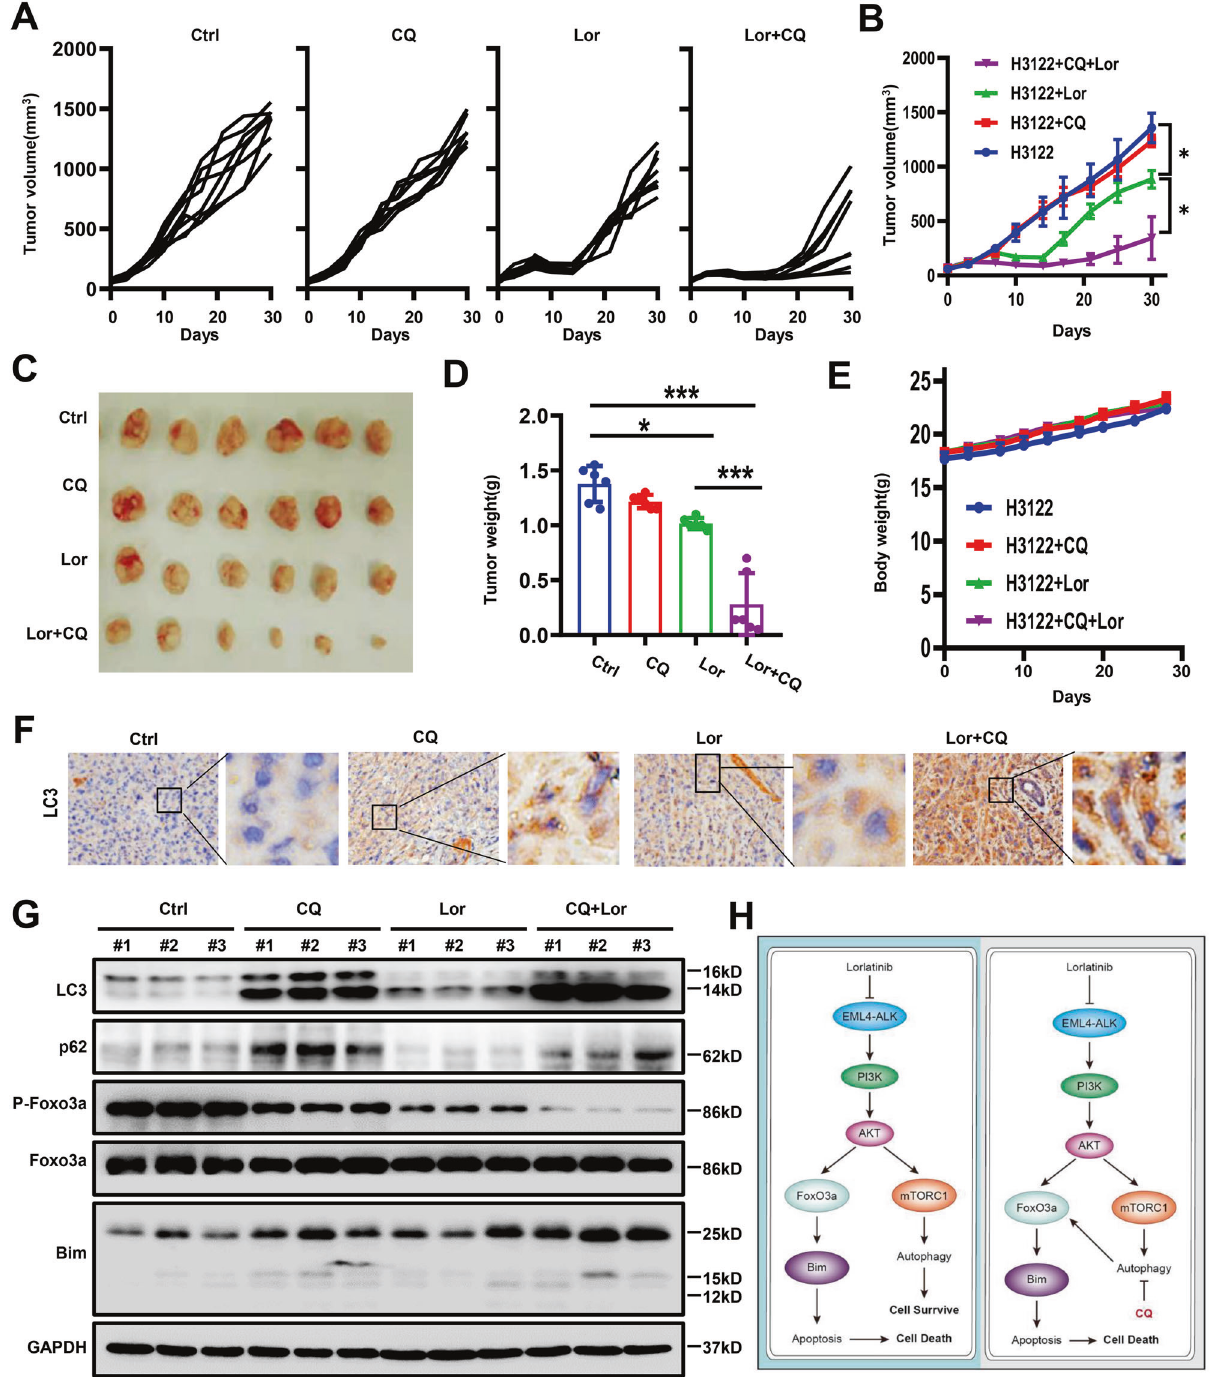
Fig. 5 Inhibition of tumors in vivo by lorlatinib and CQ. A , B Tumor sizes are presented as the mean ± S.E.M. ( n = 6); * P < 0.05. C Macroscopic appearance of H3122 xenografts treated with control, CQ, lorlatinib, and combined CQ/lorlatinib for 4 weeks. D Average tumor weight for each group was calculated. * P < 0.05. *** P < 0.001. E Body weight is presented as the mean ± S.E.M. ( n = 6). F Representative images of IHC staining of LC3. G Whole-protein cell lysates were prepared randomly from three tumors per group for western blot to detect the indicated proteins. H The mechanism served to enhance the cytotoxicity of lorlatinib by inhibiting protective autophagy and then promoting Foxo3a nuclear translocation. Ctrl control, Lor lorlatinib, CQ positive NSCLC cells results in acquired resistance by itself. We used two cell lines to con fi rm that lorlatinib could induce autophagy and that this autophagy effect was protective in ALK- positive NSCLC cells. Previously, activation of survival promoting